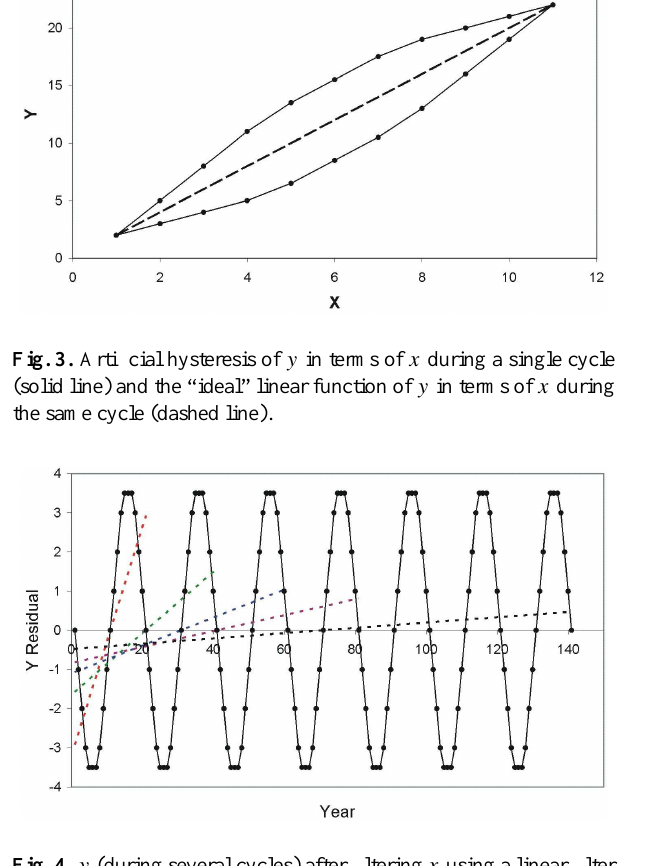
Fig. 4. y (during several cycles) after filtering x using a linear filter Figure 4. y (during several cycles) after filtering x using a linear filter (solid black line), and the linear trends obtained if only one cycle is used (red dashed line), two (green (solid black line), and the linear trends obtained if only one cycle is dashed line), three (blue dashed line), and following on. used (red dashed line), two (green dashed line), three (blue dashed line), and following on.